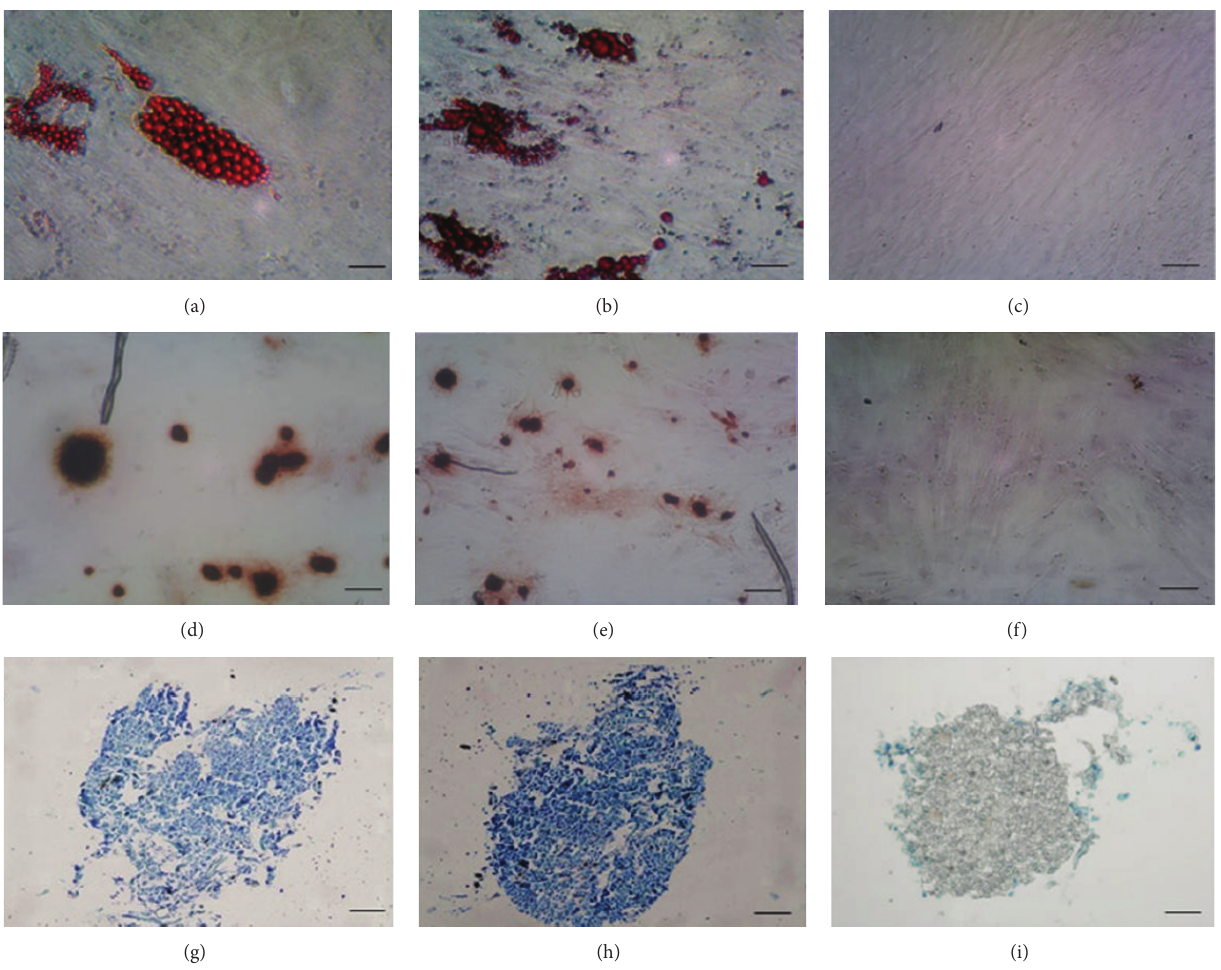
Figure 3: Morphological characteristics of lipocytes, osteoblasts, and chondrocytes induced to differentiate from bone marrow mesenchymal stem cells (BMMSCs), skin mesenchymal stem cells (SMSCs), and skin fibroblasts. (a) Lipocytes induced to differentiate from BMMSCs. (b) Lipocytes induced to differentiate from SMSCs. (c) Skin fibroblasts maintained the original cell morphology and were not stained by oil red O after induction to lipocytes. (d) Osteoblasts induced to differentiate from BMMSCs. (e) Osteoblasts induced to differentiate from SMSCs. (f) Skin fibroblasts maintained the original cell morphology and were not stained by alizarin red solution after induction to osteoblasts. (g) Chondrocyte pellet induced to differentiate from BMMSCs. (h) Chondrocyte pellet induced to differentiate from SMSCs. (i) Skin fibroblast micromasses were not stained by toluidine blue after induction to chondrocytes. Scale bar: 50 𝜇